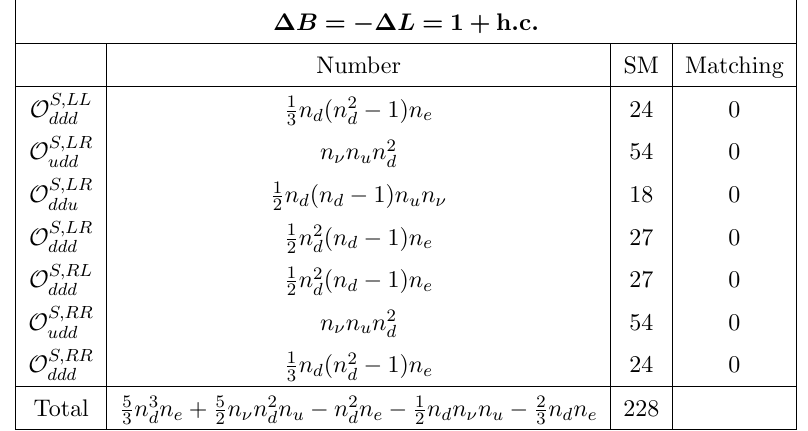
Table 21 . Dimension-six ∆ B = ∆ L = 1 operators in LEFT. There are also Hermitian conjugate − ∆ B = ∆ L = 1 operators, as indicated in the table heading. The second column is the number − − of operators for an arbitrary number of neutrino flavors n ν , charged lepton flavors n e , u -type quark flavors n u , and d -type quark flavors n d , and the third column is the number in the SM LEFT with n ν = 3, n e = 3, n u = 2, and n d = 3. The last column is the tree-level matching coefficient in